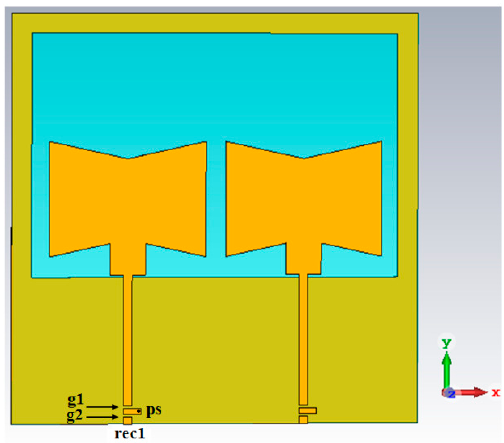
Figure 9. The layout of the rectenna and the positions at which the matching network (MN) elements and the rectifier were connected.